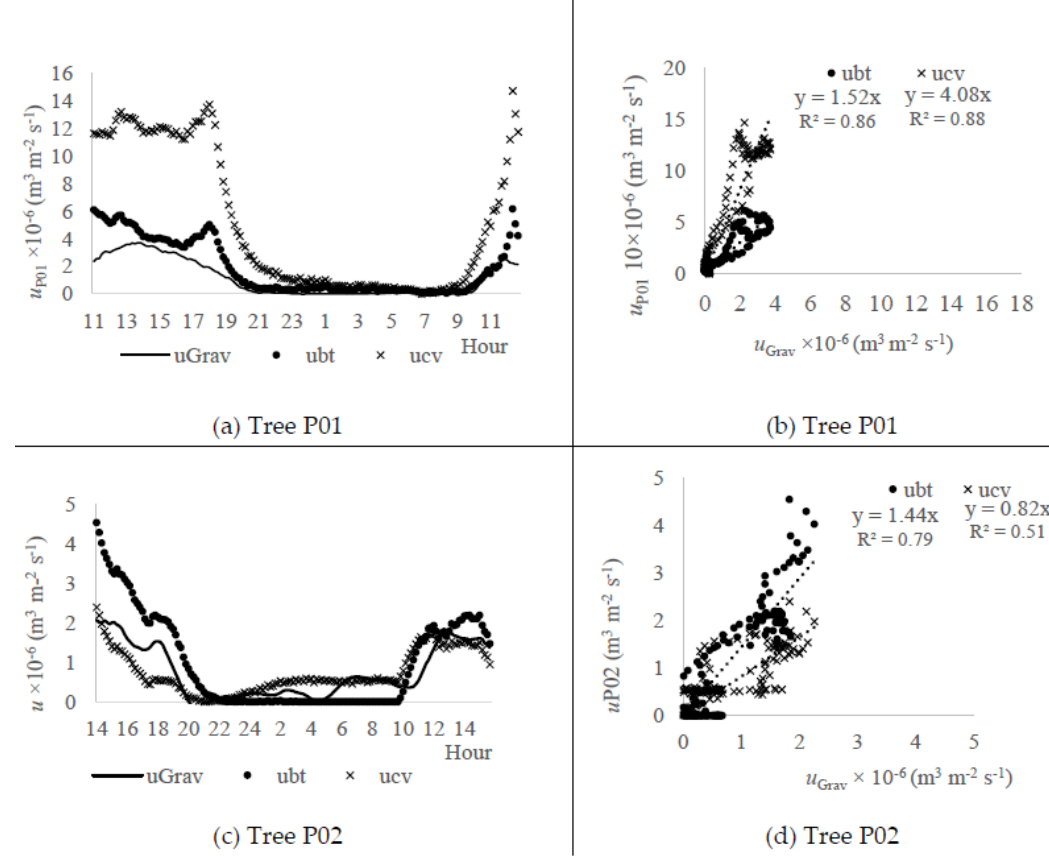
Figure 5. Values of sap flux density computed after the Biot approach ( u bt , m 3 m − 2 s − 1 ) and the conventional Granier approach ( u cv , m 3 m − 2 s − 1 ) in comparison with the sap flux density observed with the gravimetric test ( u Grav , m 3 m − 2 s − 1 ) on the sensor (Experiment I): ( a ) P01, circadian curves (26–27 March 2018); ( b ) P01, regression curve u Grav versus u bt and u cv ; ( c ) P02, circadian curves (27–28 March 2018); ( d ) P02 regression curve u Grav versus u bt and u cv .